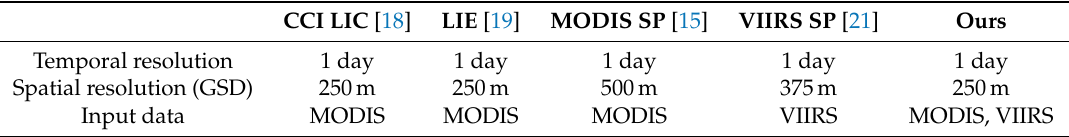
Table 1. Comparison of specifications of our machine learning-based product with the operational products such as CCI Lake Ice Cover (CCI LIC), Lake Ice Extent (LIE), MODIS Snow Product (MODIS SP), and VIIRS Snow Product (VIIRS SP). CCI LIC [18] LIE [19] MODIS SP [15] VIIRS SP [21] Ours Temporal resolution 1 day 1 day 1 day 1 day 1 day Spatial resolution (GSD) 250m 250m 500m 375m Input data MODIS MODIS